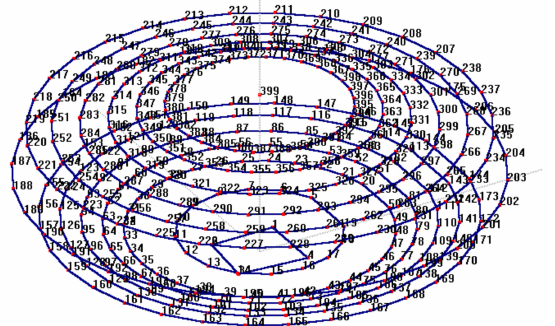
Figure 3. Measurement